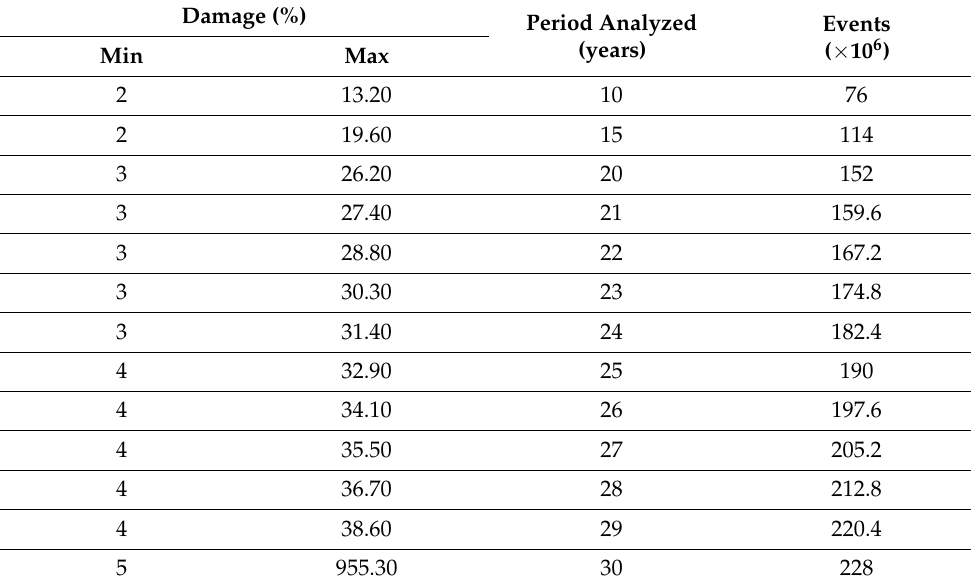
Table 3. Fatigue study results.